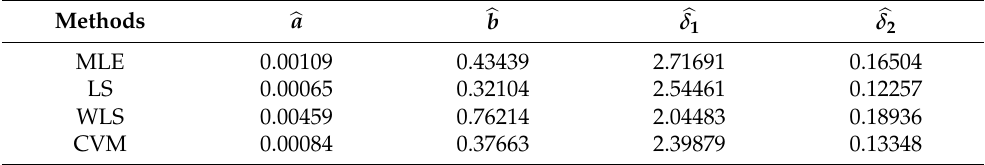
Table 12. The estimations for all estimation methods under the GRR-RW model.